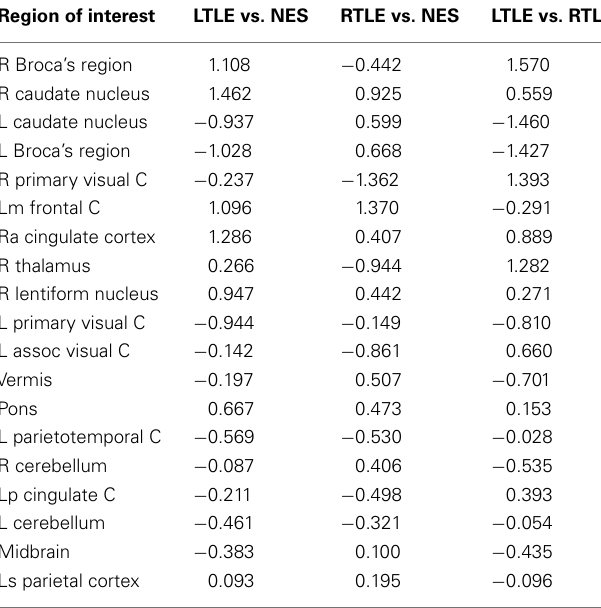
Negative t-values in the first two columns indicate the hypometabolism in epilepsy. Negative t-values in the last column indicate hypometabolism in LTLE compared to RTLE.The leading L or R indicates left or right.The lowercase let- ters indicate inferior (i), lateral (l), median (m), anterior (a), and posterior (p).The lagging C signifies cortex. Bold indicates significant differences at greater than the 95% confidence level.The markings of *, **, and *** indicate significance at the 95, 99, and 99.9% confidence level, respectively, without multiple testing correction. No t-statistics remain significant at the 95% confidence level after Bonferroni